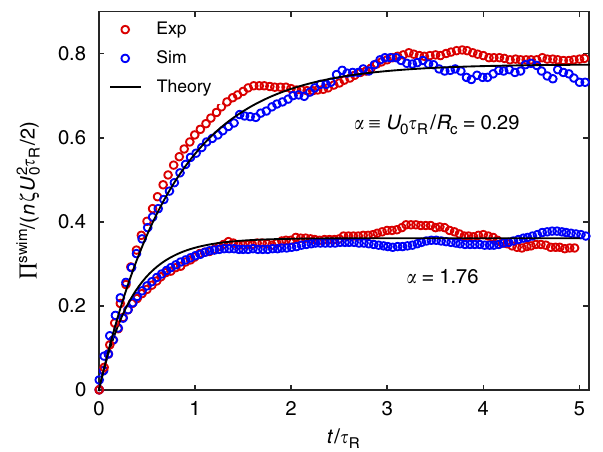
Figure 5 | Swim pressure of Janus particles in different degrees of confinement. The parameter a (cid:5) U 0 t R = R c is a ratio of the particles’ run length to the trap size R c ¼ z U 0 / k . The solid black curves are the theoretical prediction with a harmonic trap approximation, and the red and blue symbols are results from experiments and Brownian dynamics simulations, respectively. A smaller trap size diminishes the distance the particles travel between reorientations and decreases the swim pressure. The experimental and simulation data are averages of 150 and 90 independent particle trajectories for a duration of 40 s for the a ¼ 0.29 and a ¼ 1.76 cases,